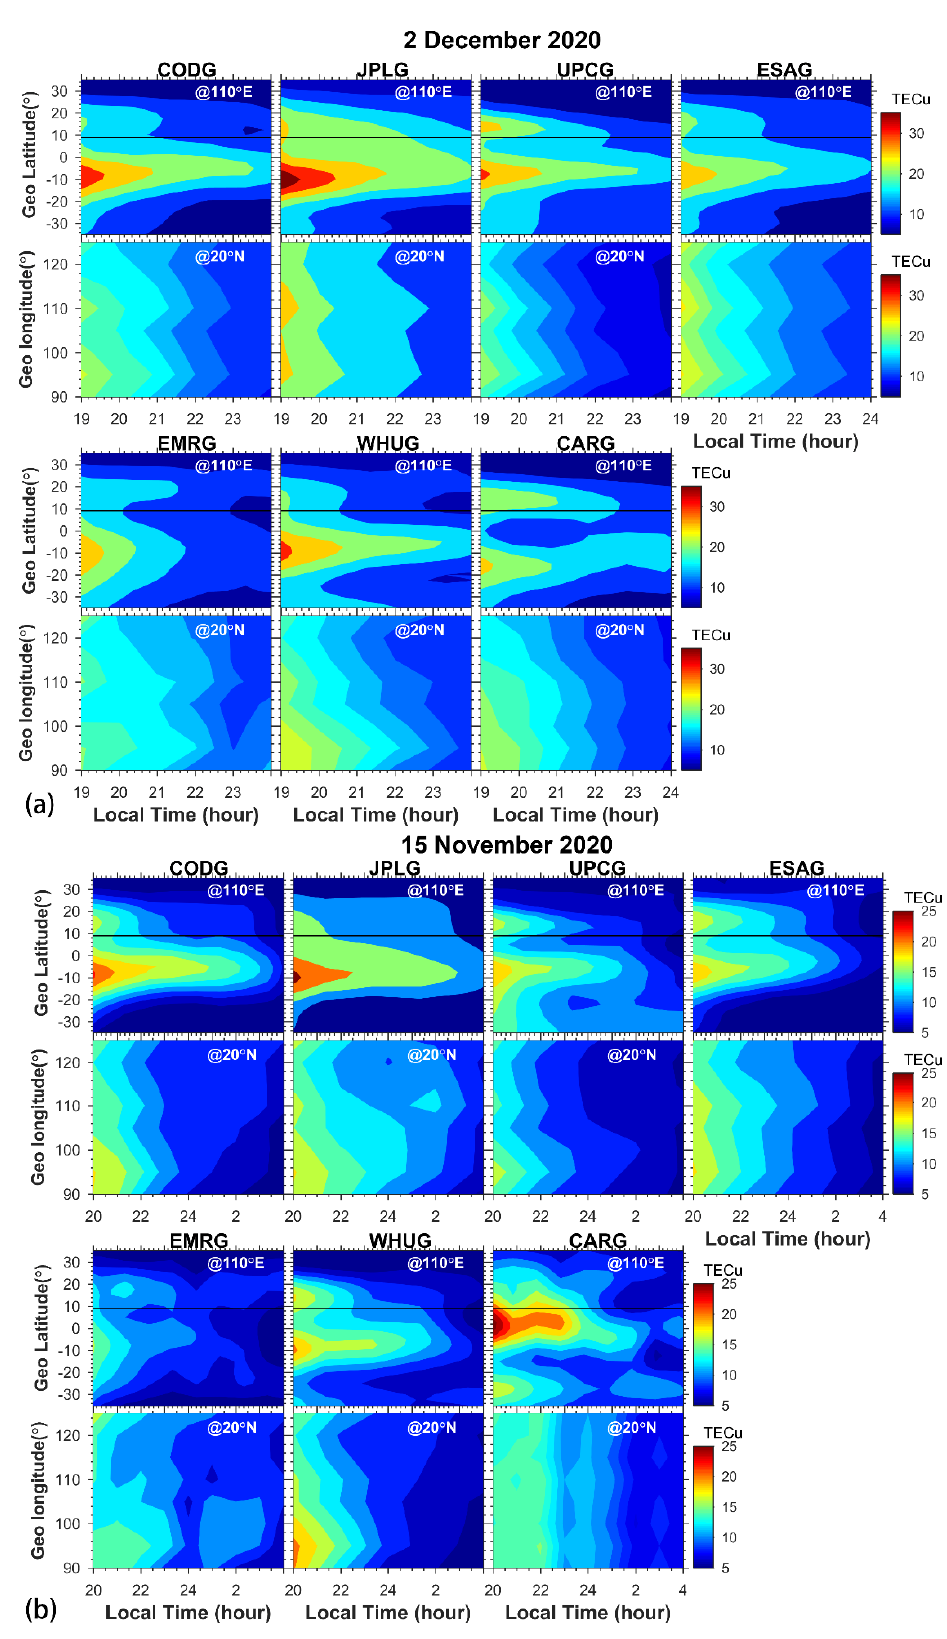
Figure 7. Contour maps of TEC from CODE, JPL, UPC, ESA, EMR, WHU, and CAS GIMs at 110° E